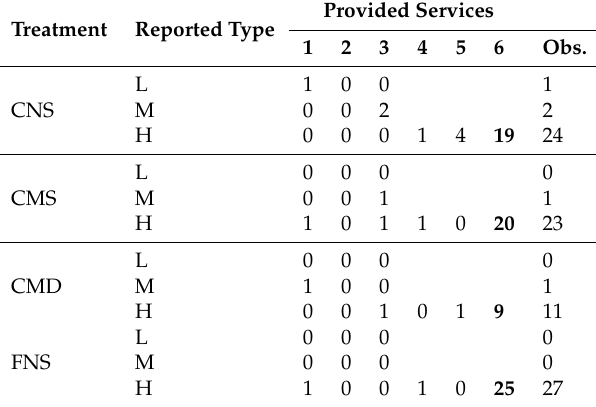
Table A14. Reporting and provision of medical services for Type H Patients . Treatment Reported